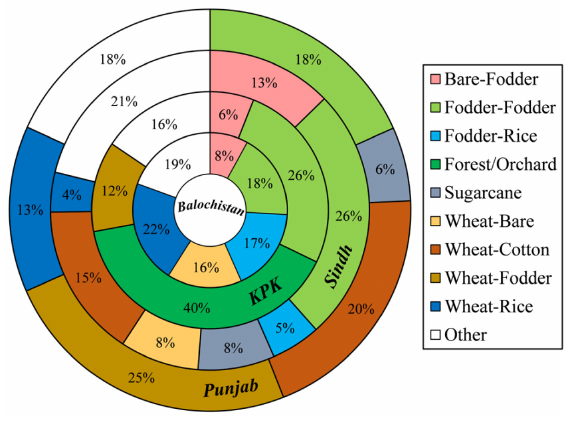
Figure 5. Fraction of different crop rotation in each